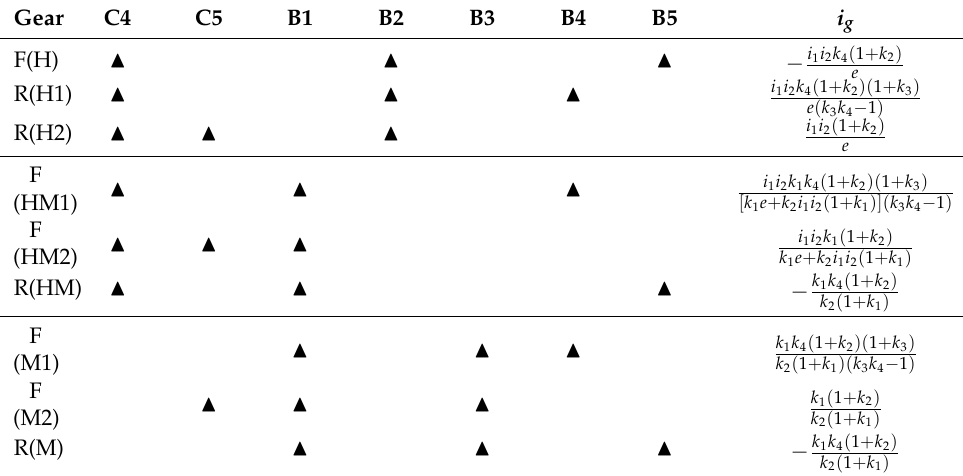
Table 2. Element engagement status and transmission ratio of each gear.